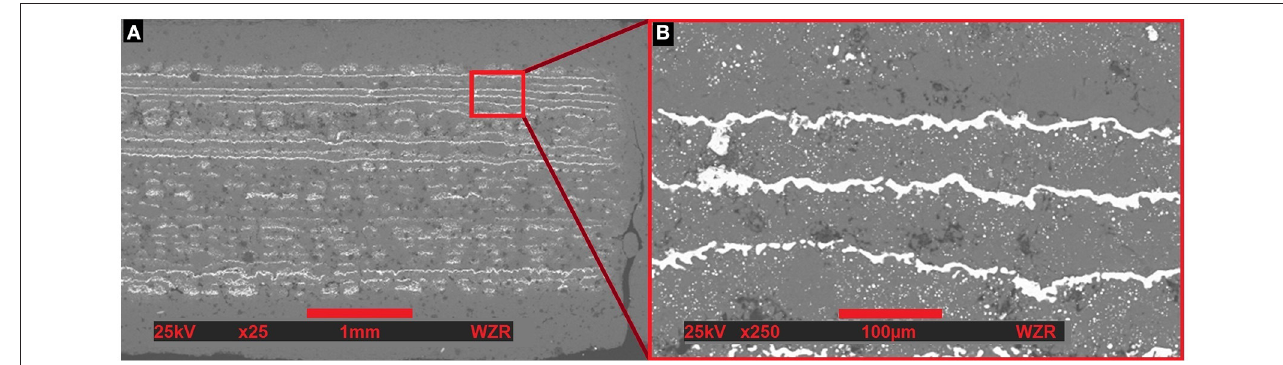
FIGURE 5 | Scanning Electron Microscopy of a cross-section of the second prototype with a magnification level of 25 (A) and 250 (B). Here the better division of silver binder and the higher silver concentration in the binder lead to some almost continuously formed layers, whereas other layers still show many gaps. Another result is that some elements of two different layers come pretty close to each other (e.g., picture B at the upper left corner). This should significantly decrease the breakdown voltage, or even could cause a direct shortcut.